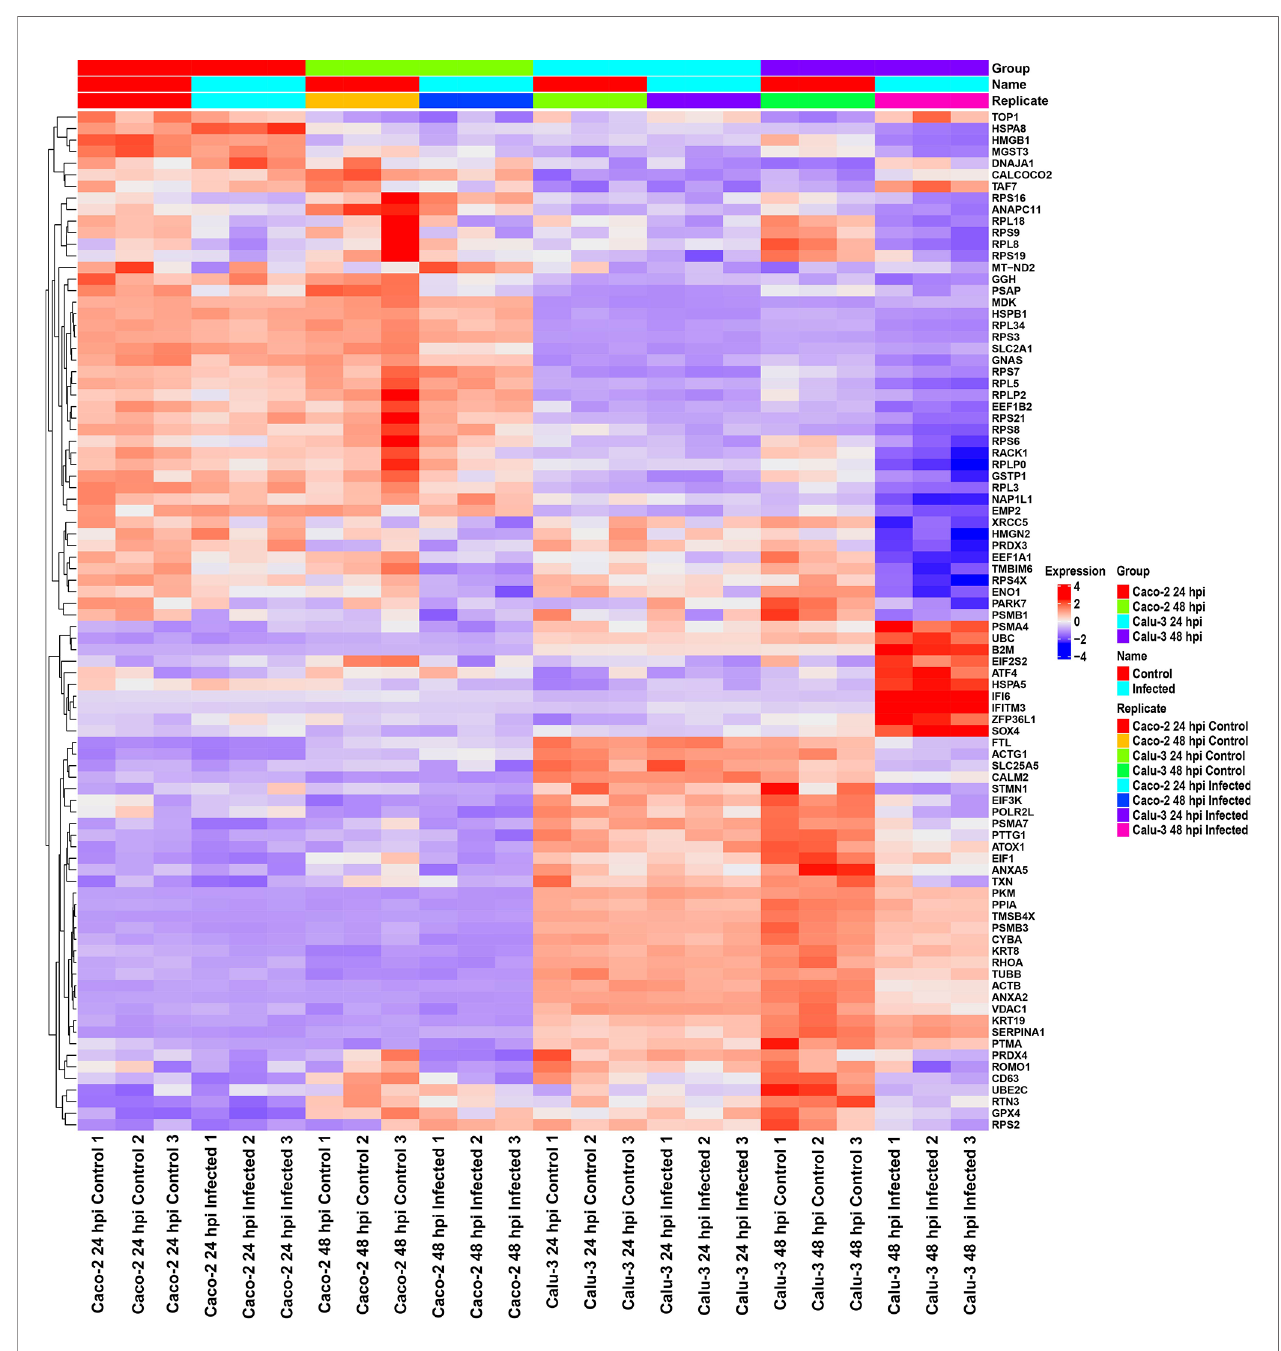
FIGURE 2 | Heatmap of relative gene expression in Caco-2 and Calu-3 cells at 24 and 48 hpi using direct cDNA datasets reveal distinct gene expression pro fi les in each cell line, analyzed by DESeq2 and visualized by ComplexHeatmap . The expression levels were scaled per row and organized based on relevant GO terms. In Calu-3 cells, higher relative expression of interferon-response genes was observed compared with Caco-2 cells. In contrast, Caco-2 cells showed higher relative expression of ribosomal protein and mitochondrial genes. These results further validate the cell-type-speci fi c responses to SARS-CoV-2. The data was fi ltered by padj < 0.05, enrichment p-value < 0.0001. Related to Figures 1 , S1 and Table 2